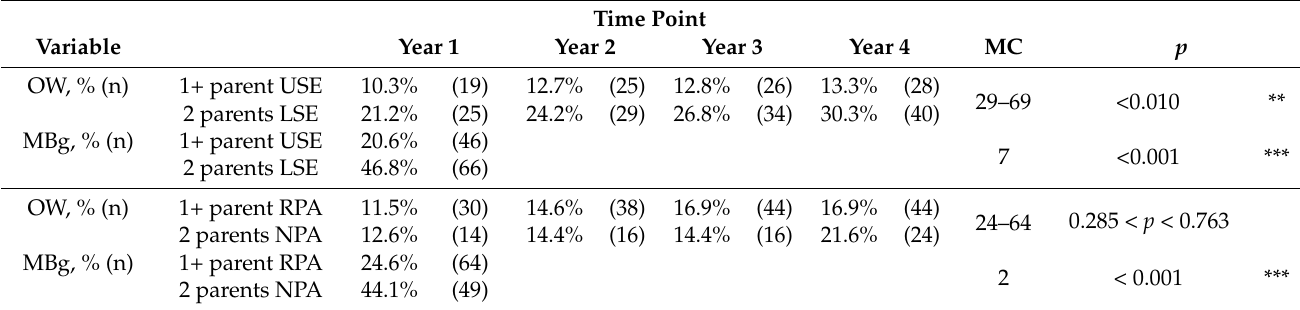
Table 3. Weight status and migration background distributions separately for children with parental education group and parental physical activity